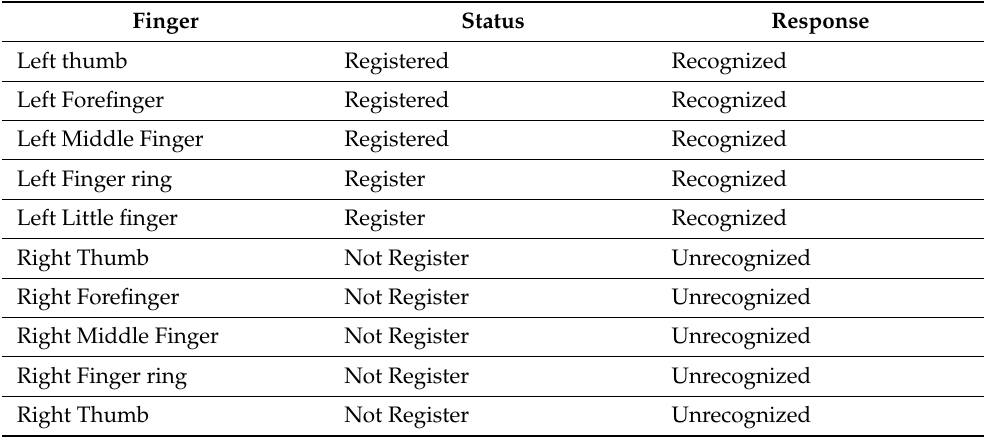
Table 3. Testing of registered and unregistered Table 3. testing of registered and unregistered fingerprints. Table 3. testing of registered and unregistered fingerprints.